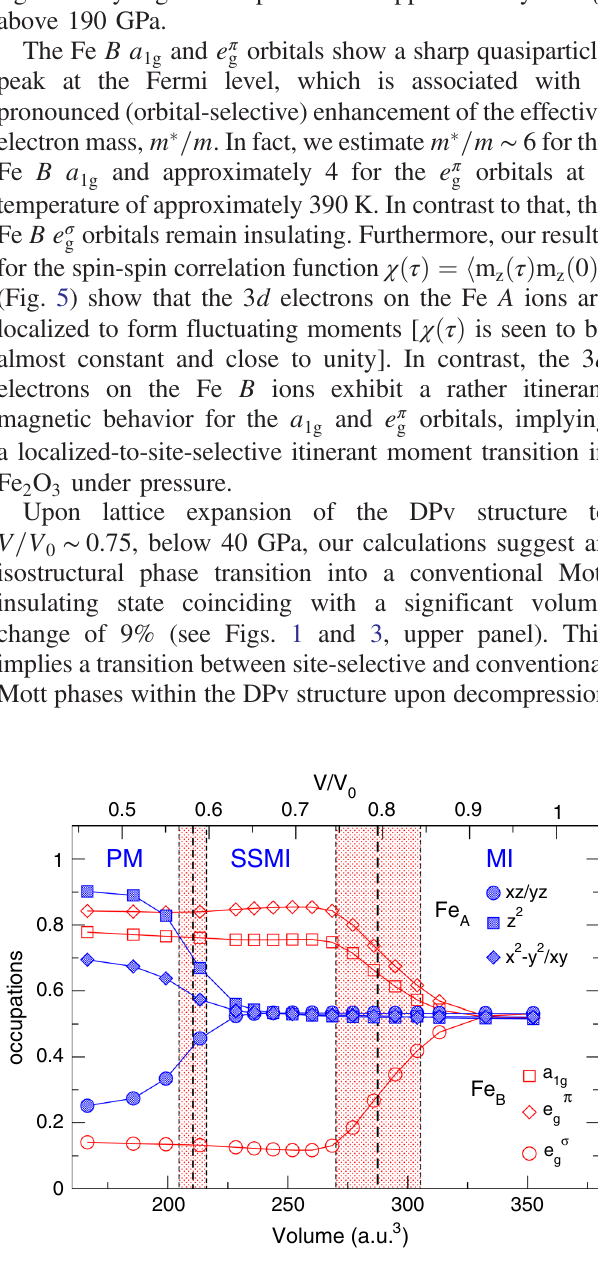
FIG. 4. Partial Fe 3 d occupations of paramagnetic DPv Fe 2 O 3 calculated by DFT þ DMFT as a function of lattice